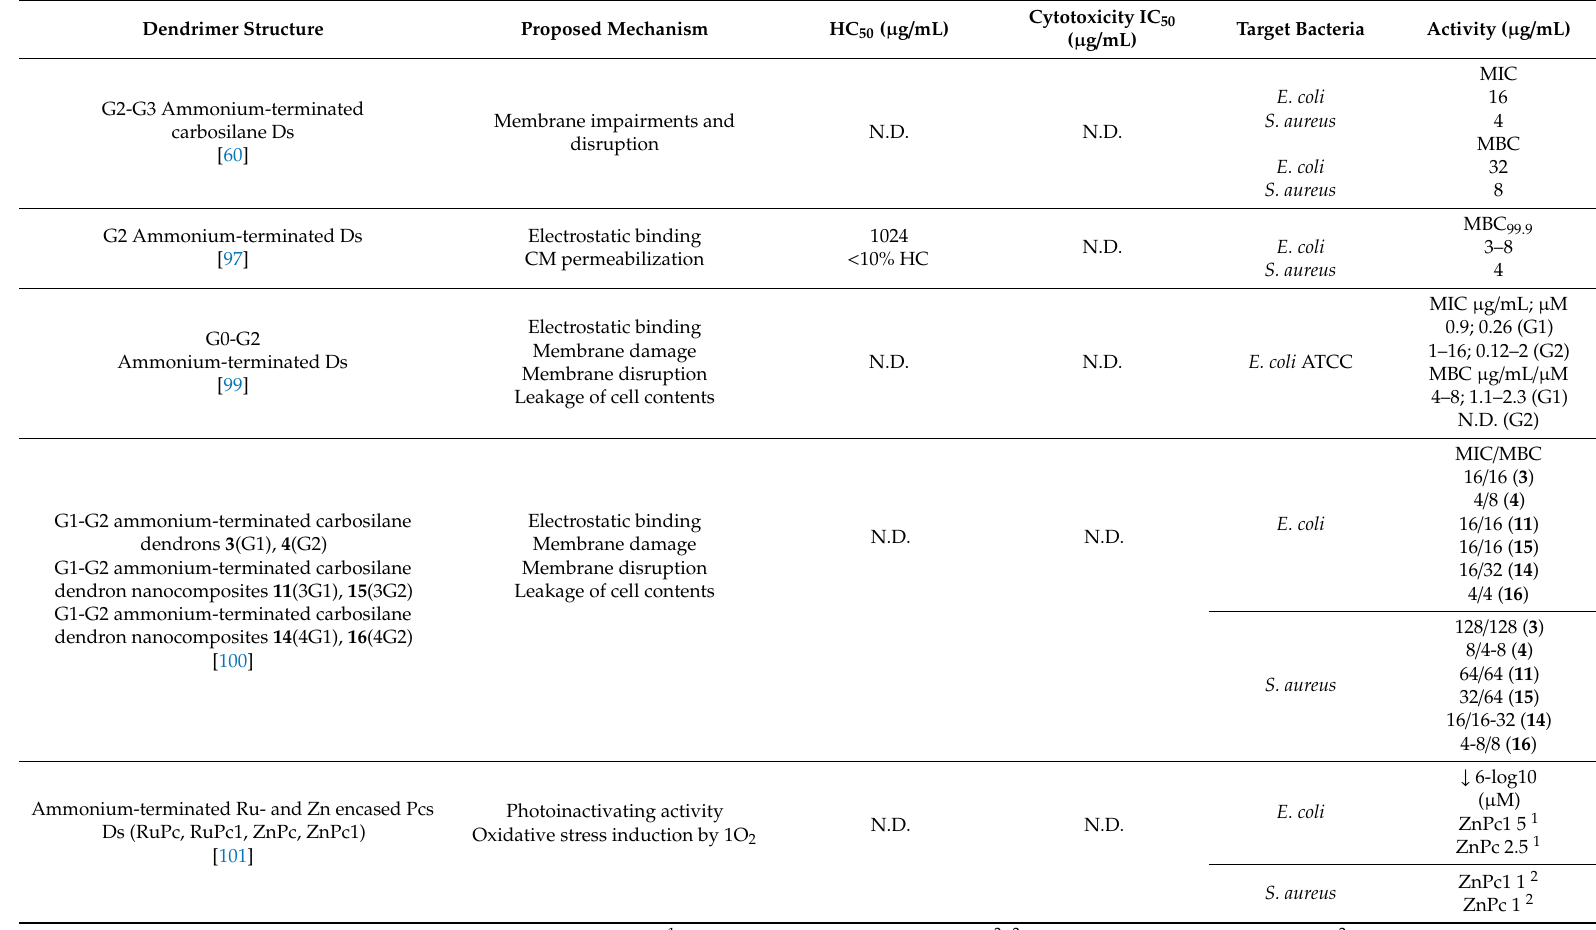
Table 9. Most representative ammonium-terminated antibacterial Ds and some of their variations developed in the last decade and antibacterial activity of the most e ff ective ones among the synthetized